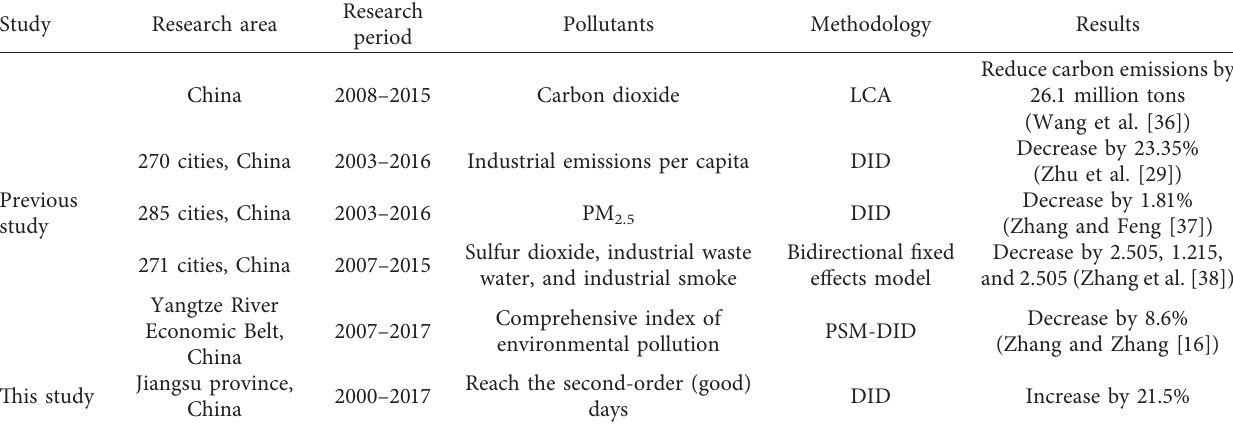
Table 7: Comparisons of high-speed rail opening